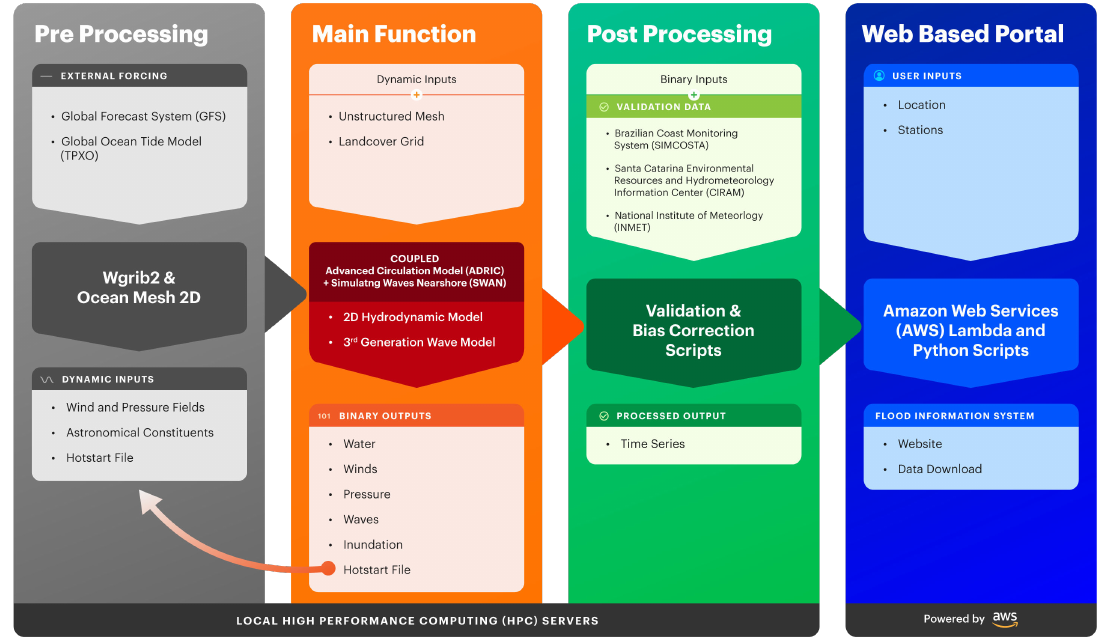
Figure 2. Operationalization framework for integrated flood for Brazil (iFLOOD-Brazil)